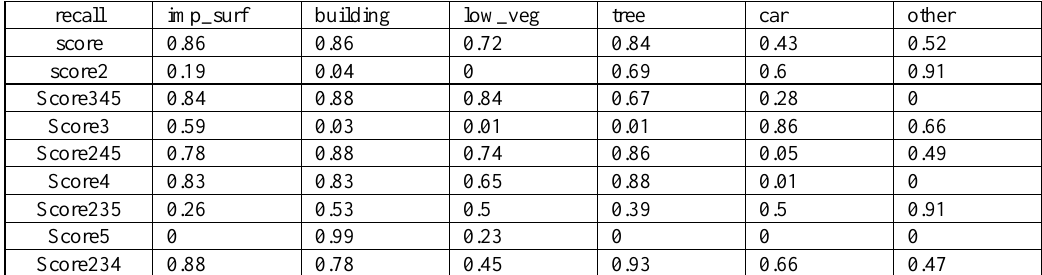
Figure 3. The contribution of layer 3 for car: When layer 3 is removed, cars are mostly not detected anymore, as other layers are not sensitive enough for cars. Table 1. The recall of different layers for different classes for color features.